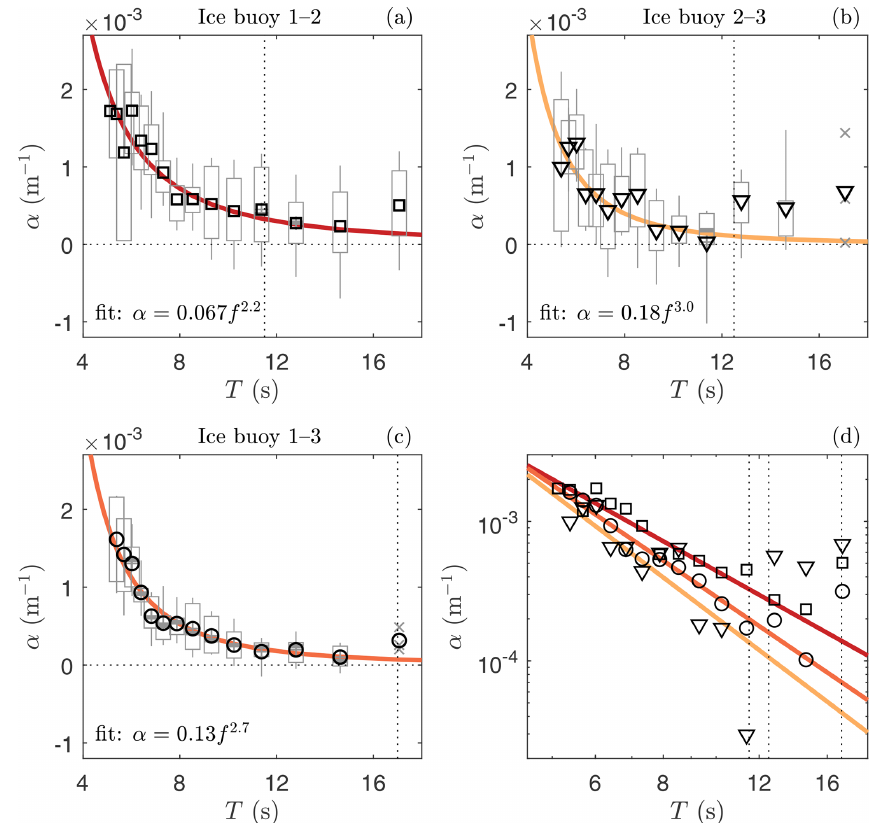
Figure 7. Mean wave attenuation rate α (markers) observed during the Arctic experiment and estimated based on buoy pairs: (a) 1–2, (b) 2–3, and (c) 1–3 (see also Fig. 3a). Ice buoys 1, 2, and 3 are positioned 500, 1100, and 1800m from the estimated landfast ice edge, respectively. In (a) – (c) , boxes identify the 25th and 75th percentiles, and the vertical bars identify the 9th and 91st percentiles. Vertical dotted lines correspond to the wave period where the buoy pair distance is 3 times the wave length. Best fits to the experimental data are provided in color and presented in log-scale in (d)